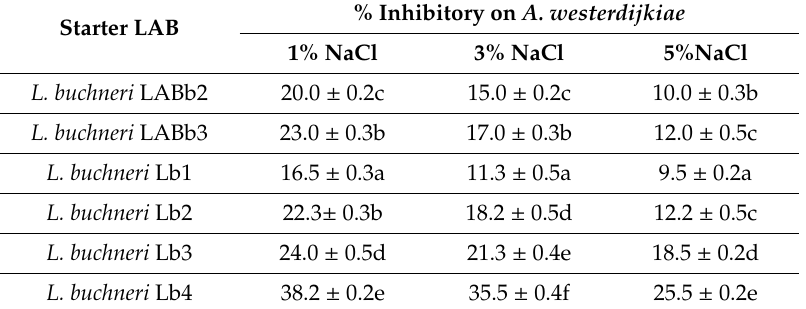
Table 3. Percentage of inhibitory activity of Lactobacillus buchneri vs A. westerdijkiae co-inoculated in agar plates.